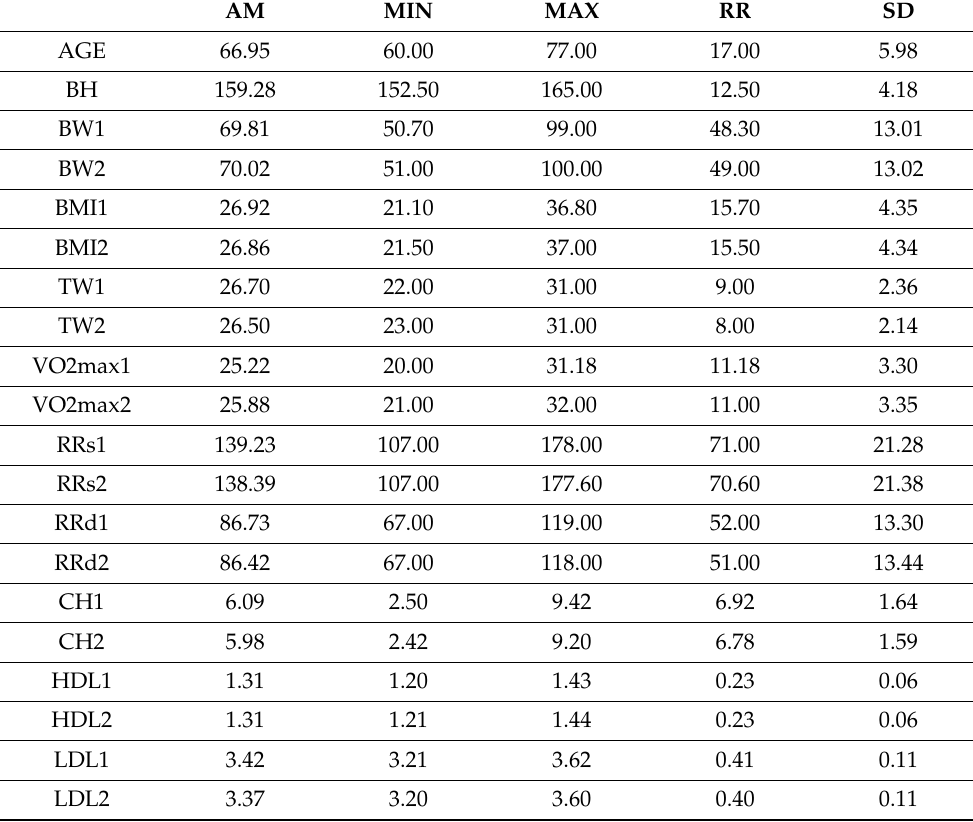
Table 1. Descriptive parameters of the 1st experimental group (initial and